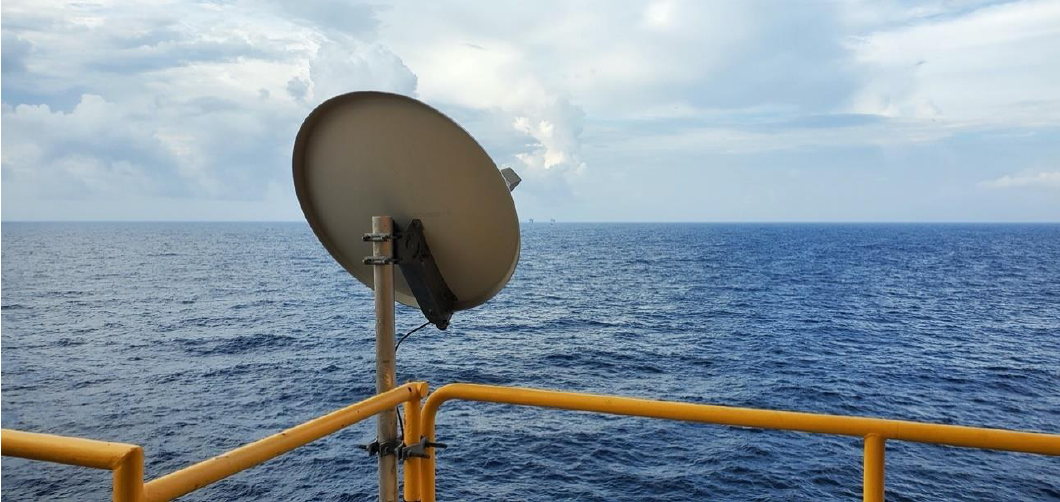
Figure 15. A SmartLNB installed on an oil rig in the Gulf of Mexico (EUTELSAT 117WA coverage).